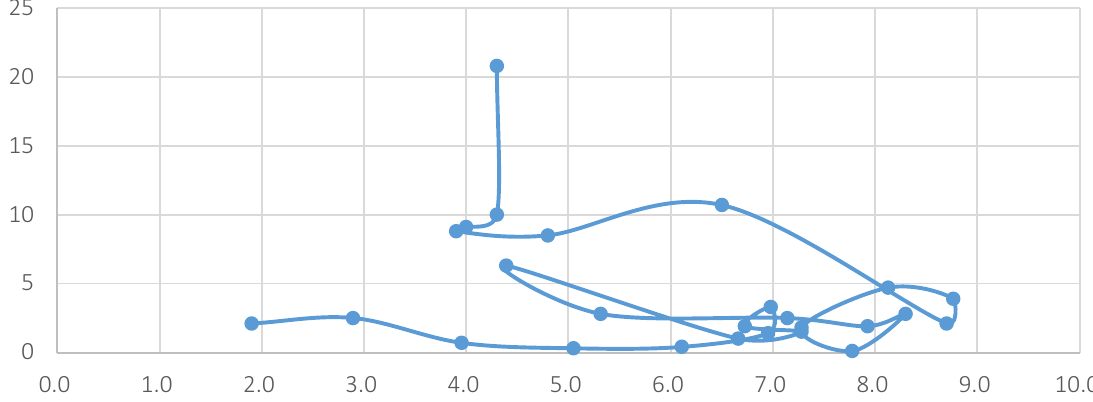
Figure 3. Relationship between the unemployment rate and inflation rat Table 2. Statistics data for the unemployment